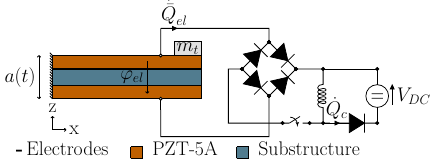
Fig. 5 Bimorph electromechanical structure coupled toan SECE cir- cuit.